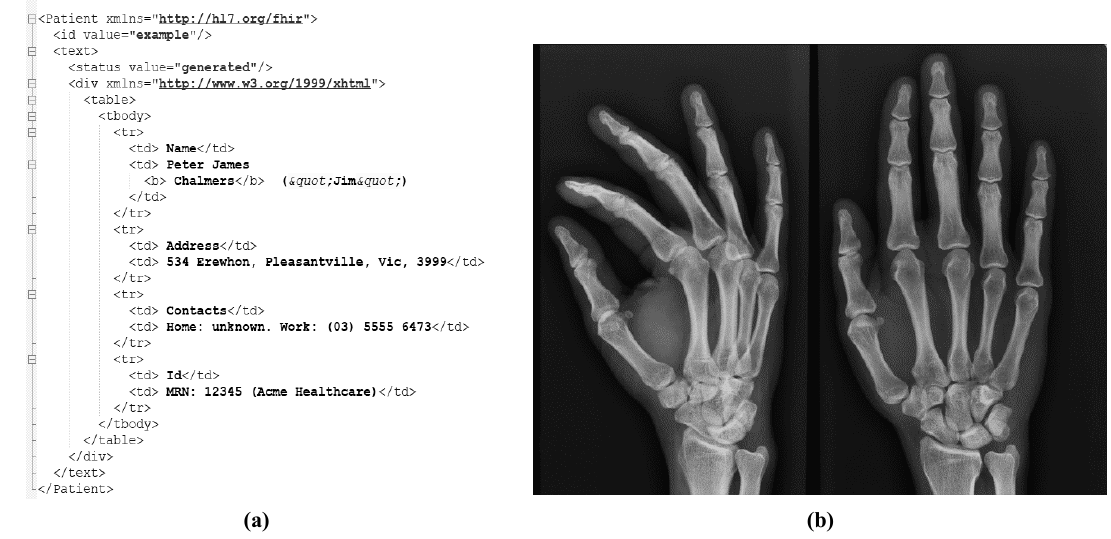
Figure 6. (a) Sample of exchange image, (b) Sample of exchanged textual